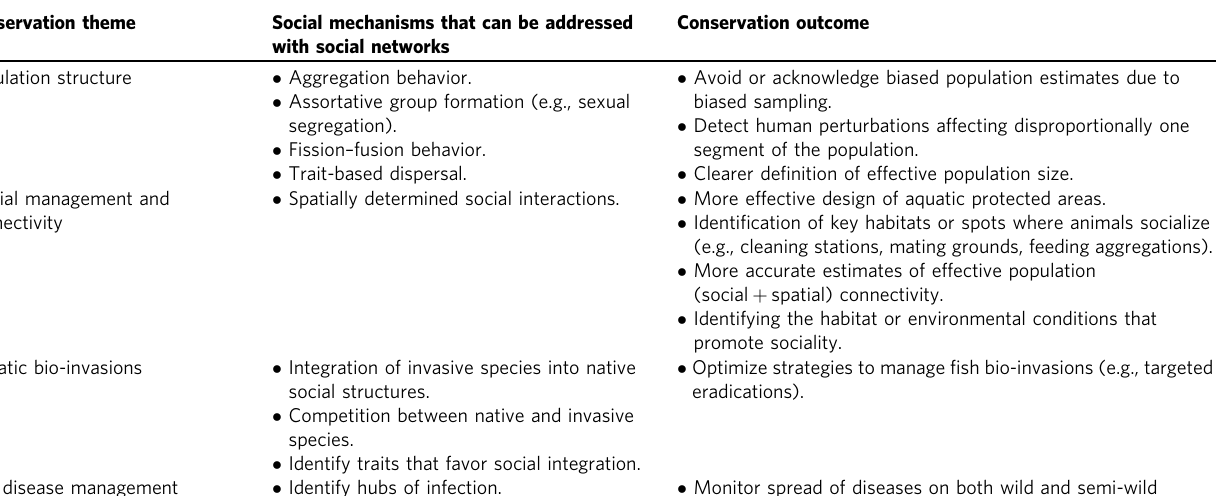
Conservation outcome